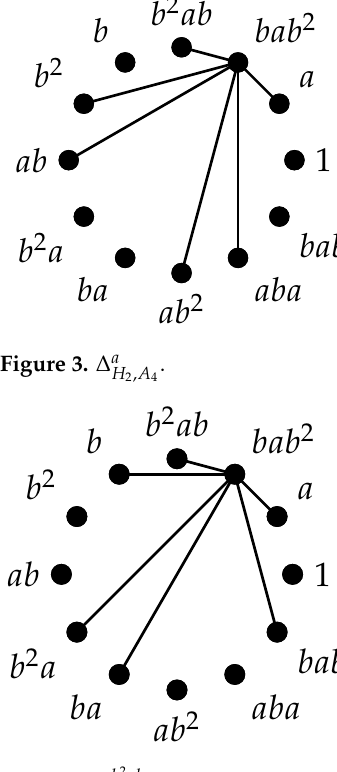
2 ab Figure 4. ∆ b 2 ab H 2 , A 4 H 2 , A 4 2 H 3 , A 4 H 3 , A 4